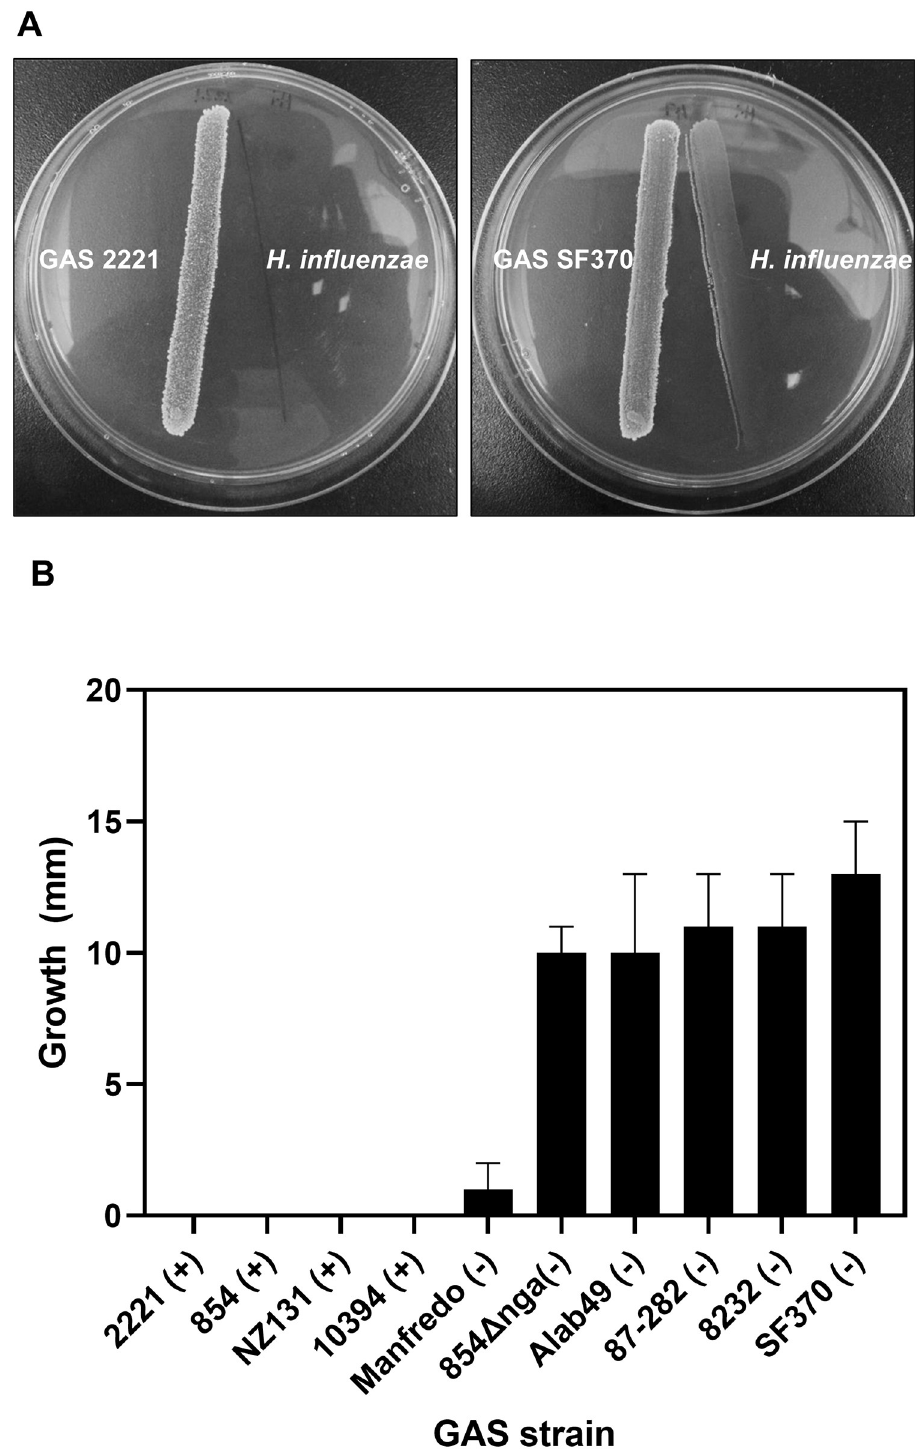
Fig 3. Certain GAS strains can support NAD + -dependent growth of H . influenzae . A . GAS 2221, NADase-positive, and GAS SF370, NADase-negative, were inoculated in a streak on hBHI agar (supplemented with heme but not NAD + ) at a divergent angle from a streak of H . influenzae strain 2019. B . Growth of H . influenzae on NAD + -deficient BHI agar supported by disks inoculated with NADase-positive (+) or NADase-negative (-) GAS strains. Data represent width of the rings of H . influenzae growth surrounding the GAS disks and are the mean of three biological replicates ± standard deviation.